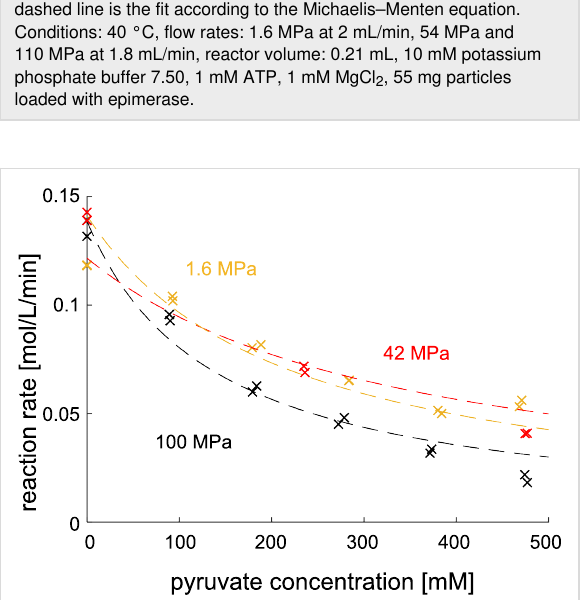
Figure 9: Measured reaction rate of the immobilized epimerase as a function of pyruvate and pressure. Dashed lines are fitted to a competi- tive inhibition model, 40 °C, volume flow: 2 mL/min, 440 mM GlcNAc, 100 mM buffer, 0.21 mL reactor volume, 2.25 min waited for steady state, 57 mg particles loaded with epimerase.